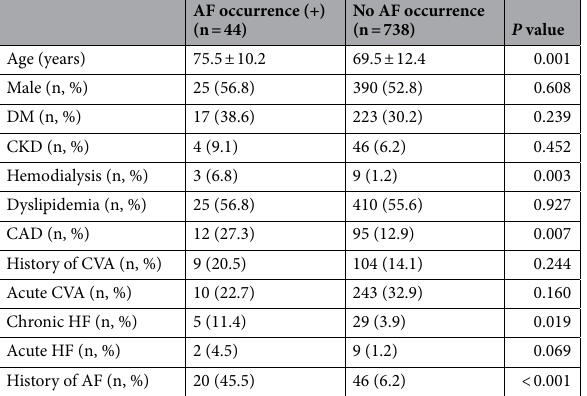
AF occurrence (+) (n =